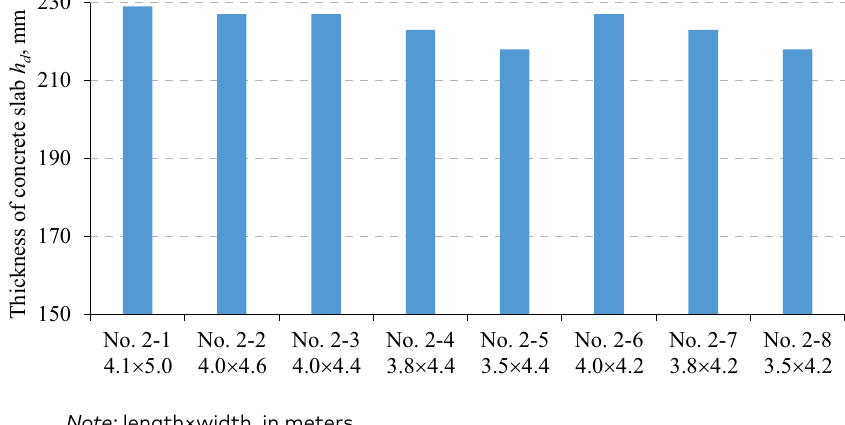
Figure 8. The effect of slab dimension on design slab thickness